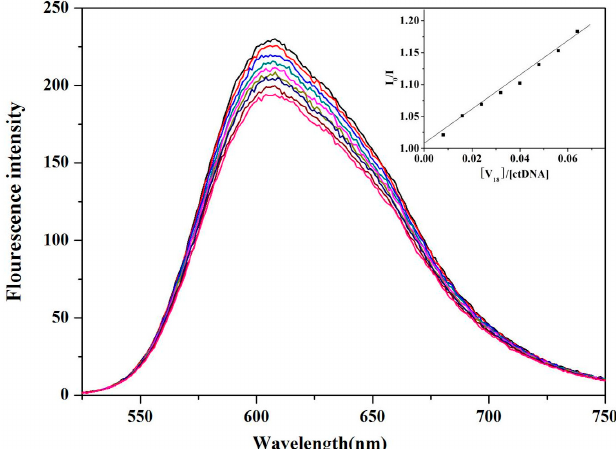
Figure 6. The fluorescence spectra of mixed EB (20 μ M) and calf thymus DNA (ct DNA; 100 μ M) in the presence of different concentrations of V 18 (0, 1.33, 2.67, 4.00, 5.33, 6.67, 9.33, 10.67, 12 μ M) in phosphate-buffered saline (PBS). It shows the fluorescence intensity changes with increasing concentrations of V 18 . Insert: Stern–Volmer plot of the fluorescence titration data of EB- ct DNA with different concentrations of V 18 in PBS.